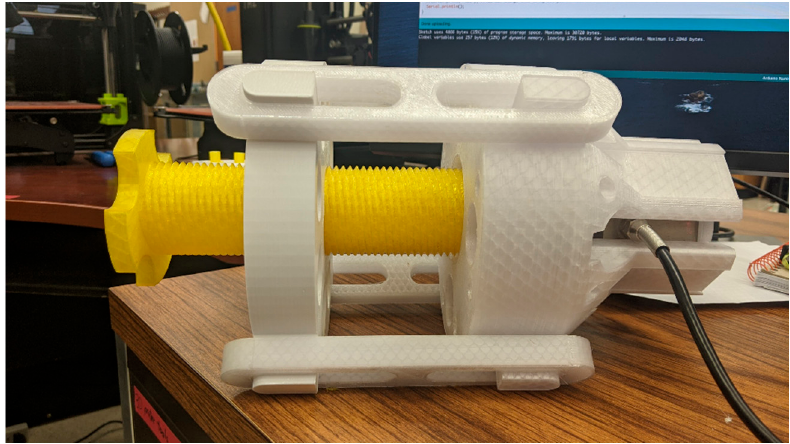
Figure 4. Image of direct press screw test assembly.